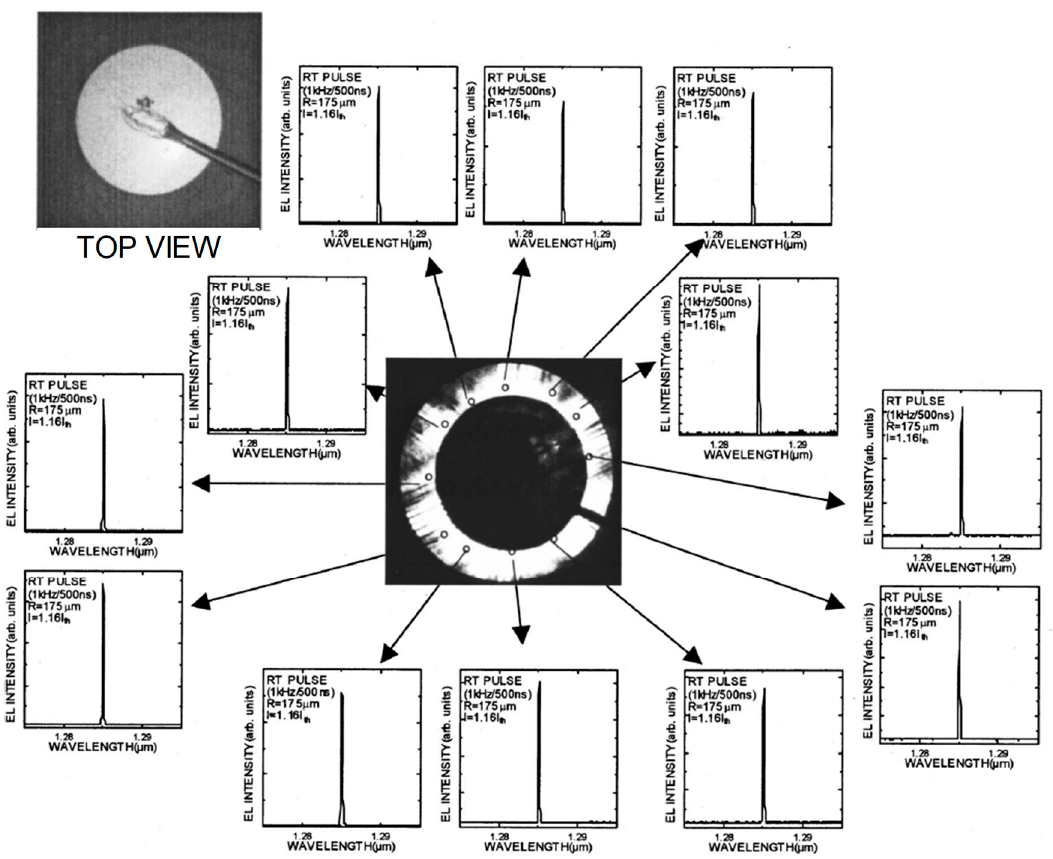
Figure 3. Lasing characteristics of a photonic crystal laser [3]. A photograph of the p-electrodes is shown in the upper left. The near-field pattern (NFP) after lasing is shown in the middle. Surrounding panels show the lasing spectra at each point. Reprinted figure with permission from [3], copyright 2002 by the American Physical Society.